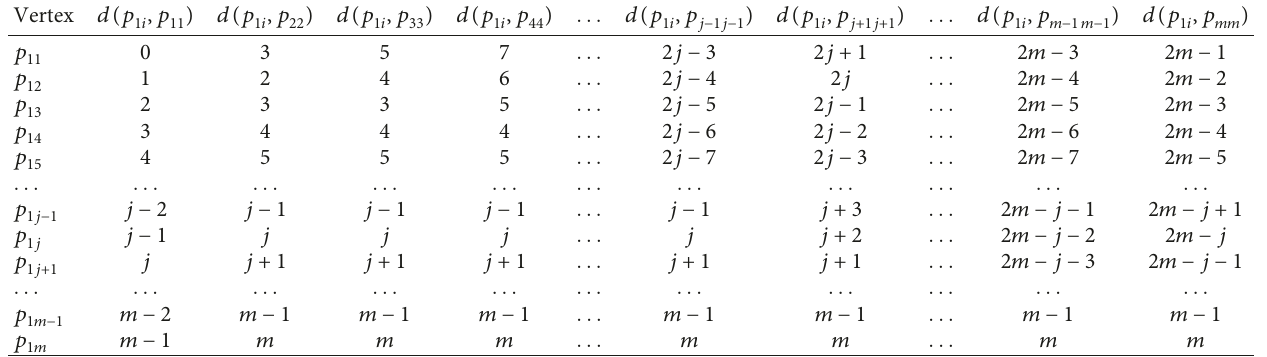
( M ) of vertices in the first cluster for 1 ≤ i ≤ m p 1 i jj